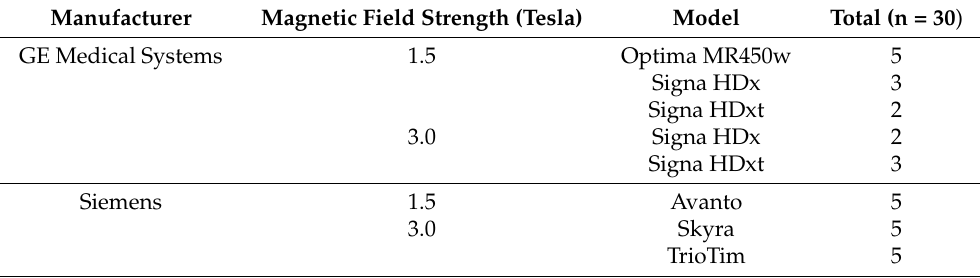
Table 2. MRI scanner information from the randomly selected subset of the external valida- tion dataset. Manufacturer Magnetic Field Strength (Tesla) Model Total (n = 30 ) GE Medical Systems 1.5 Optima MR450w 5 Signa HDx 3 Signa HDxt 3.0 Signa HDx Signa HDxt Siemens 1.5 Avanto 3.0 Skyra